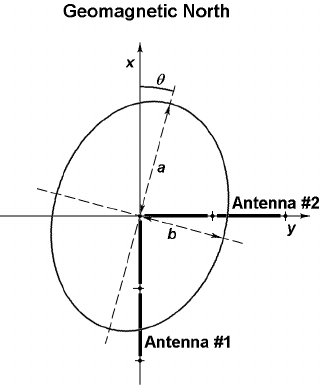
Figure 1. Orientations of the receiving antennas and the coordinate